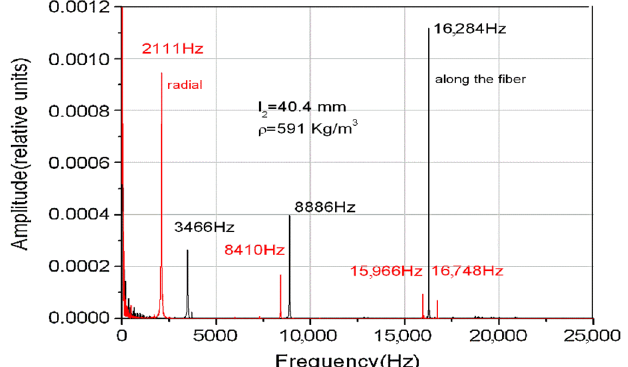
Figure 1. Fourier spectrum and the eigenmodes frequencies.